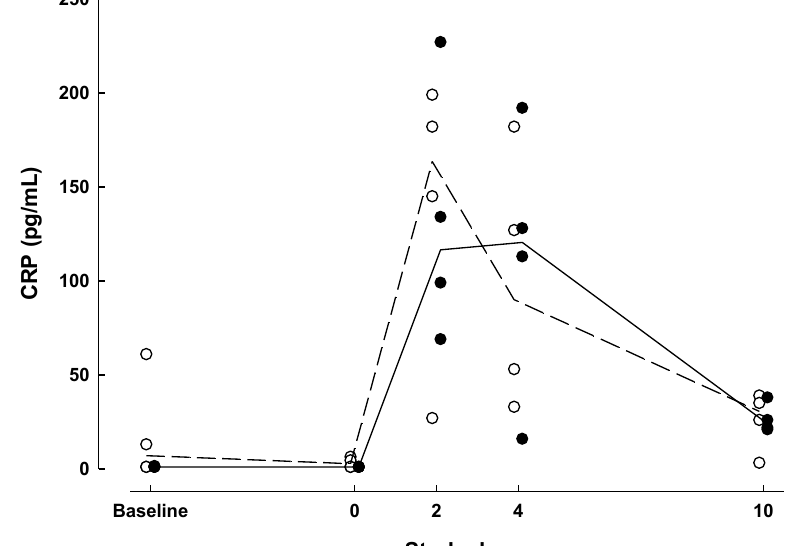
Figure 2. Inflammatory marker concentrations measured at baseline, day of surgery and on postoperative days 2, 4 and 10 in patients who received Impact preoperatively and postoperatively (IMN, solid symbols) compared with patients who received no preoperative supplemental nutrition and Isosource postoperatively (STD, open symbols). ( a ) C-reactive protein (CRP), ( b ) tumour necrosis factor (TNF)-α, ( c ) IL-6, ( d ) interleukin (IL)-10. Dashed (STD) and solid (IMN) lines connect median